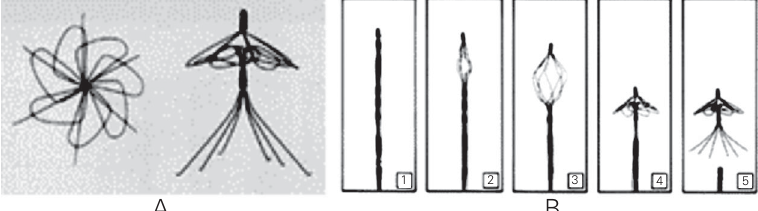
A B Figure 4. Simon filter. A , Filter in the recovery form. B , Filter release. Taken from Ref. 26 (http://www.nmtmedical.com).